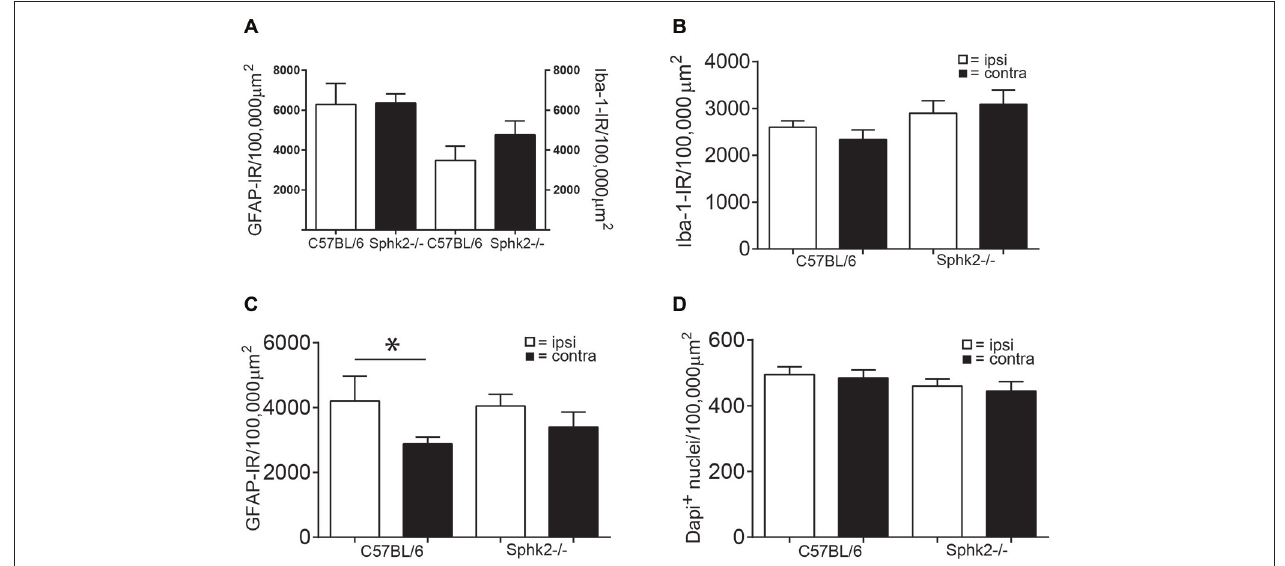
µ m 2 ( n = 10, unpaired t -test, n.s.). (C) Area with IR for GFAP in C57BL/6 and Sphk2 − / − mouse SC dorsal horn 60 min post injection of two percent formalin, normalized to 100,000 µ m 2 ( n = 10, unpaired t -test, * p < 0.05). (D) Number of nuclei immunoreactive for NeuN in C57BL/6 and Sphk2 − / − mouse SC dorsal horn 60 min post injection of two percent formalin, normalized to 100,000 µ m 2 ( n = 10, unpaired t